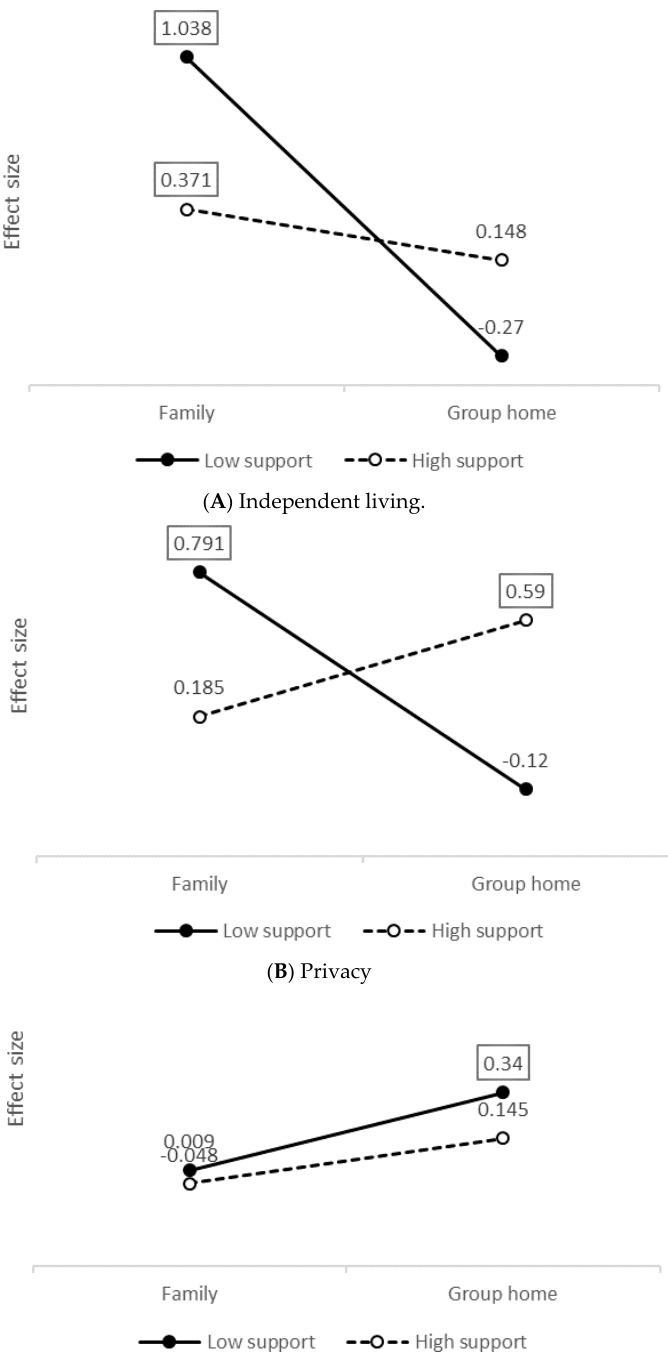
Figure 3. Size of mean differences according to degree of support needed and living environment. Note: ( A – C ) factors correspond to professional practices oriented to promote the rights included in Articles 19, 22 and 26 of the Convention, respectively. The rectangle indicates differences significantly different from zero.